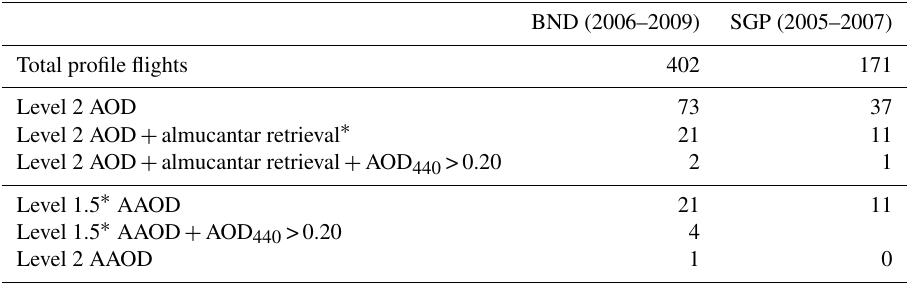
Table 2. Number of AERONET–in situ AOD and AAOD flight matches as a function of various AERONET constraints and the ± 3h time